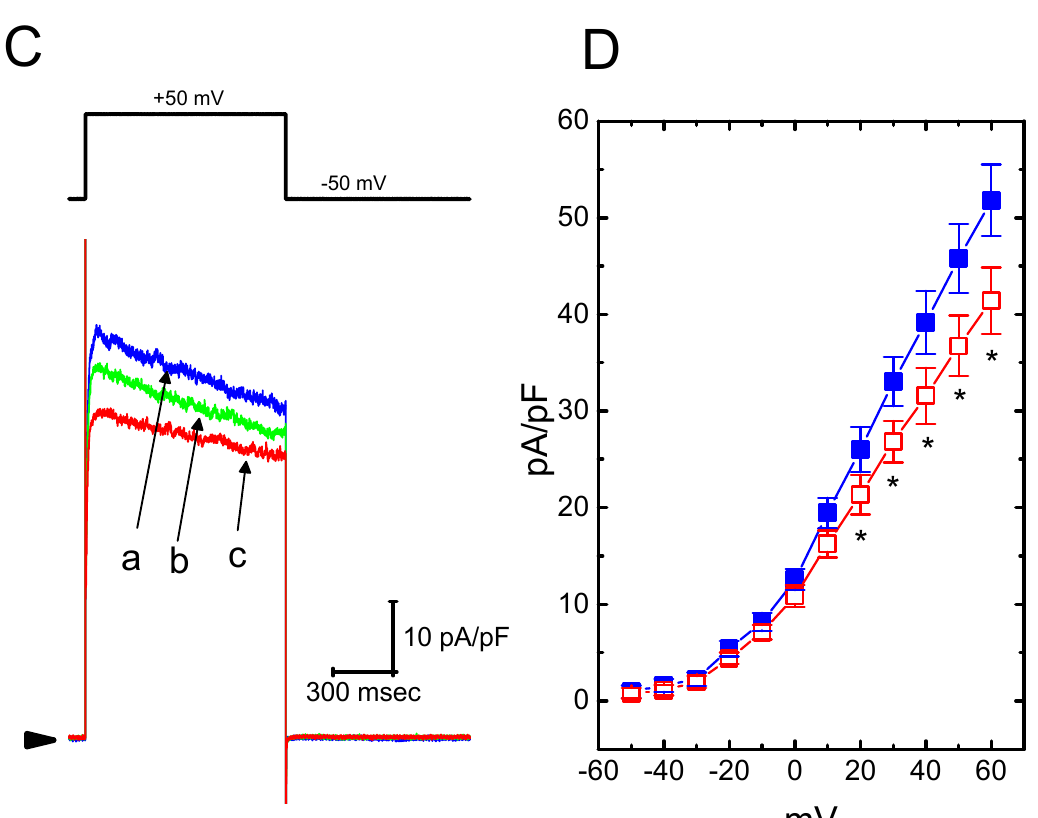
Figure 6. E ff ect of HBA on the densities of I K(erg) and I K(DR) recorded from GH 3 cells. For the recording of I K(erg) density, cells were bathed in high-K + , Ca 2 + -free solution, and to record the I K(DR) density, cells were bathed in Ca 2 + -free Tyrode’s solution containing 1 µ M tetrodotoxin. The recording pipette was filled with K + -containing solution. ( A ) Superimposed traces of I K(erg) density elicited by membrane hyperpolarization (indicated in the upper part). The arrowhead shows the zero current level. (a) control; (b) 10 µ M HBA. ( B ) Average current density–voltage relationships of I K(erg) in the absence ( (cid:4) blue) and presence ( (cid:3) red) of 10 µ M HBA (mean ± SEM; n = 9 for each point). Current density was obtained at the beginning of hyperpolarizing potentials from − 10 mV to di ff erent voltages ranging between − 110 and − 10 mV. ( C ) Superimposed traces of I K(DR) density obtained in the absence (a) and presence of 3 µ M HBA (b) and 10 µ M HBA (c). The upper part indicates the voltage protocol used, and the arrowhead is the zero current level. ( D ) Average current density–voltage relationships of I K(DR) taken with or without the addition of 10 µ M HBA (mean ± SEM; n = 11 for each point). The I K(DR) density was taken at the end of each depolarizing pulse. Asterisks shown in (B) and (D) indicate a significant di ff erence from the controls taken from the same voltage level ( p < 0.05). Note that, in comparison, the presence of HBA (10 µ M) slightly suppressed the density of I K(erg) or I K(DR) elicited throughout the entire voltage-clamp ranges examined.